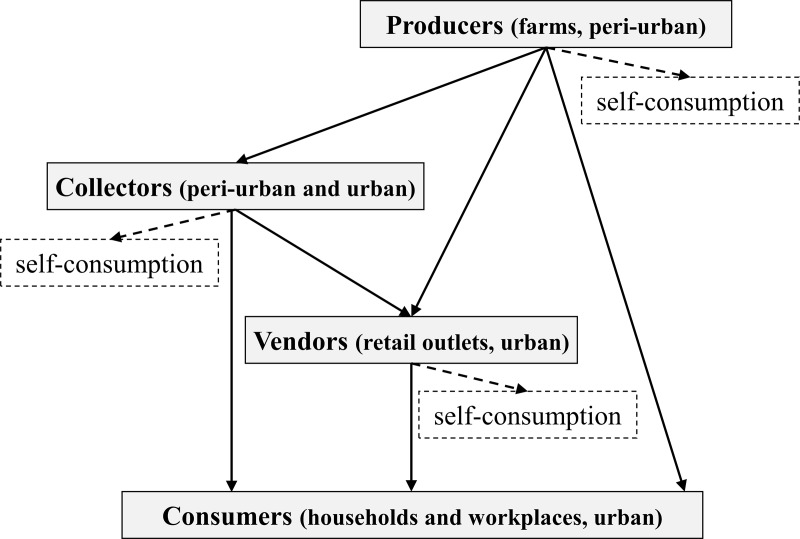
Simplified milk distribution circuit in Korhogo.